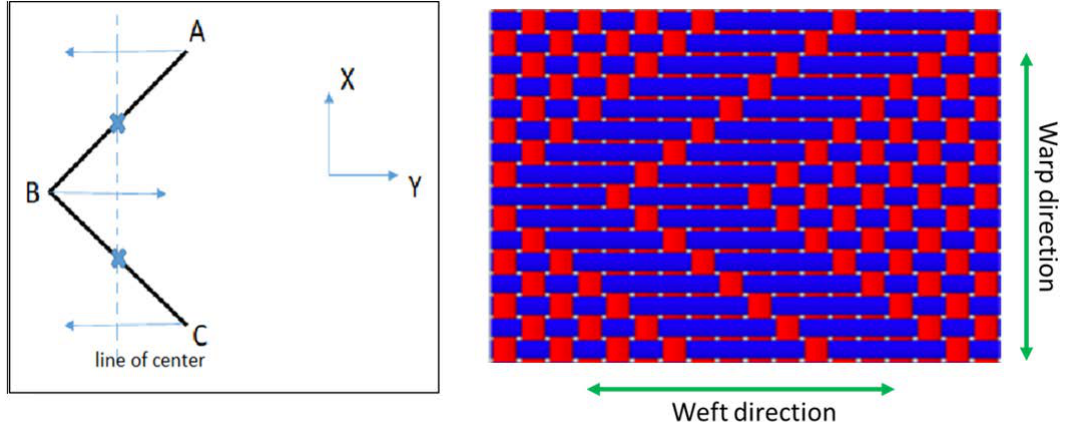
Figure 4. Couple formation in auxetic structure. (A, B, C: are nodal points of the zigzag pattern, X, Y: are axes representing warp and weft respectively)